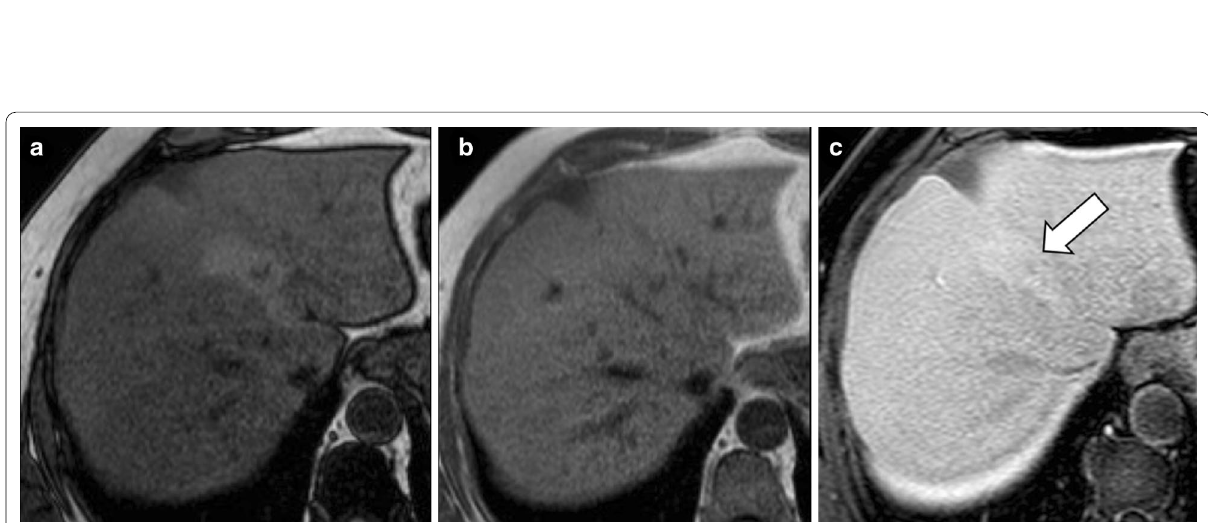
Fig. 5 A 63‑year‑old man with liver steatosis and focal fat sparing area in segment 4. Gadoxetate disodium‑enhanced MRI shows ( a ) in the opposed‑phase and ( b ) in‑phase images a fat sparing area with similar signal unlike the background liver that has marked signal drop in the opposed‑phase sequence. The area of fat sparing is ( c ) slightly hyperintense (arrow) to the background liver in the hepatobiliary